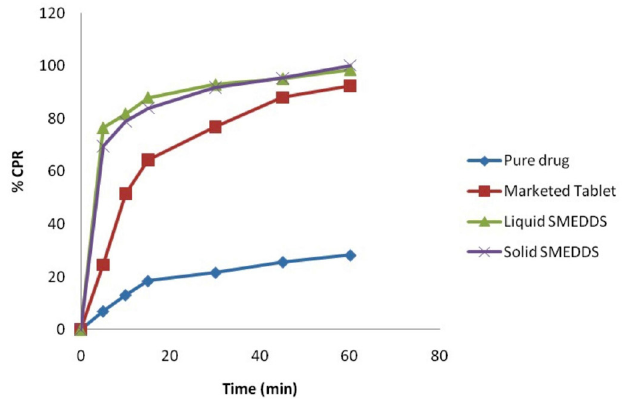
FIGURE 7 - Comparative drug release profile of pure drug, marketed product, liquid SMEDDS (batch P2) and solid SMEDDS (batch SP4).